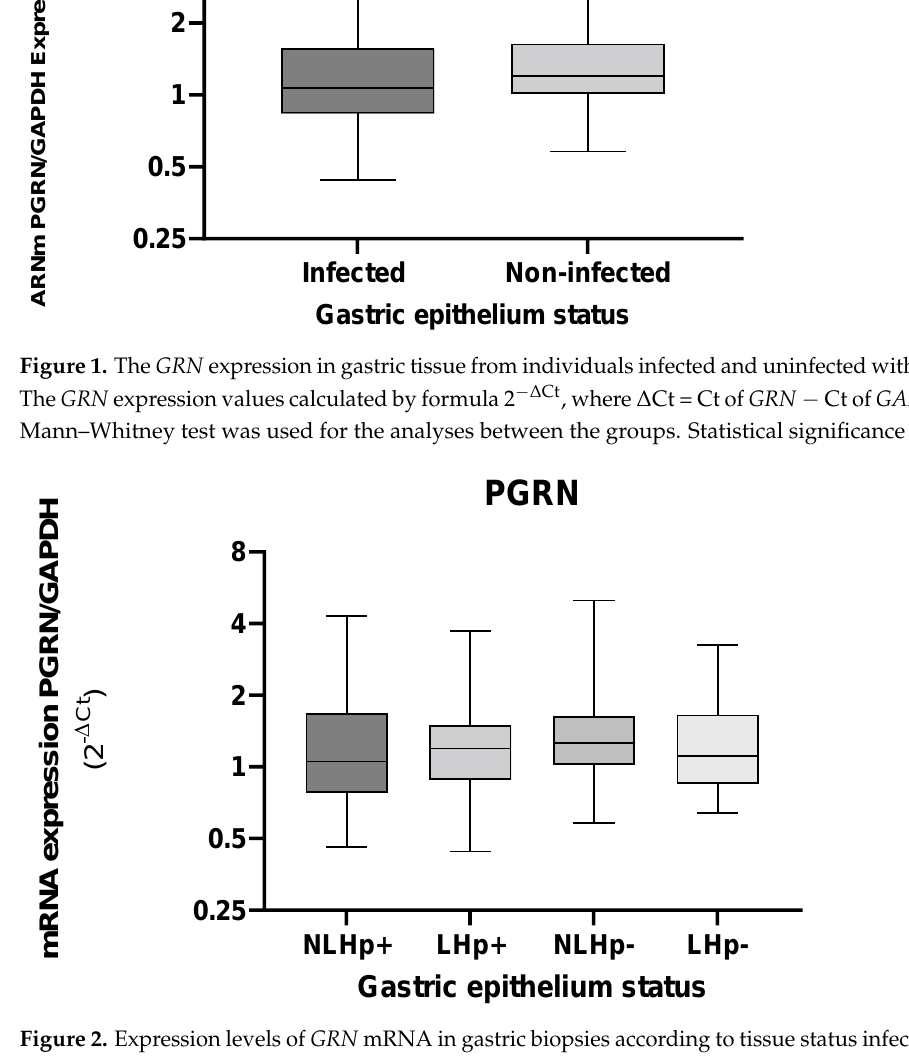
Figure 2. Expression levels of GRN mRNA in gastric biopsies according to tissue status infected (Hp+) and non- infected with H. pylori (Hp − ). Tissues with injury (L), tissues without injury (NL). The GRN expression values calculated by formula 2 − ∆ Ct , where ∆ Ct = Ct of GRN − Ct of GAPDH. The status of the gastric tissue was assigned according to the report of the endoscopic observation. The Kruskal–Wallis and Mann–Whitney was used for the analysis in or between the groups. Statistical significance <